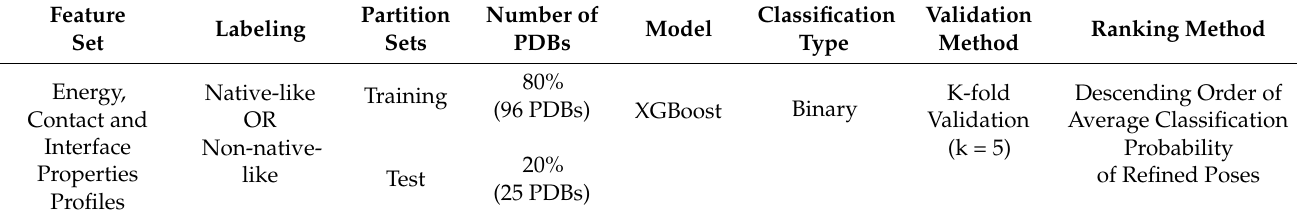
Table 3. Summary of settings used for modeling and benchmarking